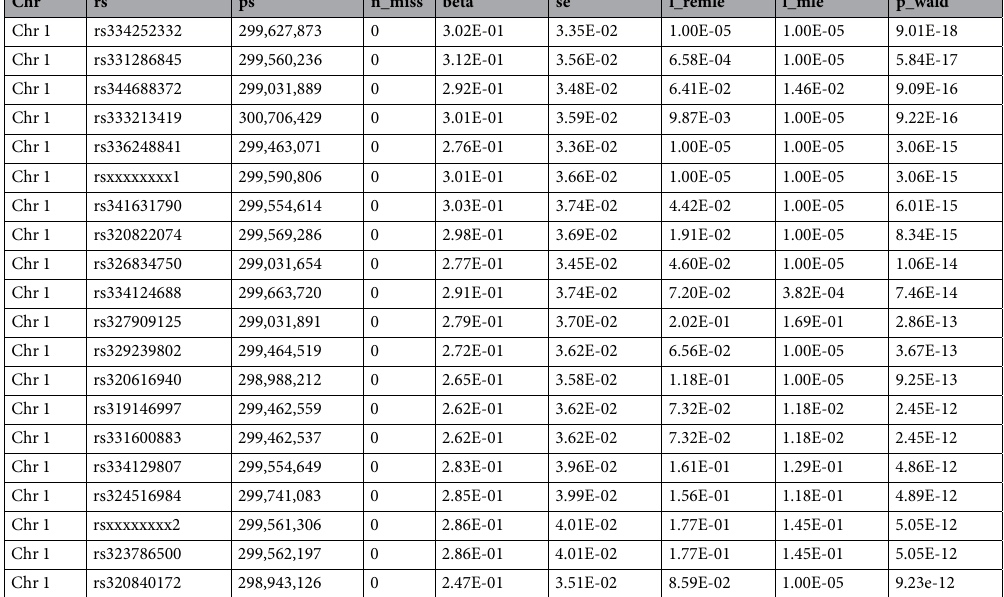
Table 3. Description of the most significant 20 SNPs associated with lumbar number by GWAS. Chr : chromosome number; rs : SNP IDs and two SNPs that do not possess rs ID were named after rsxxxxxxxx1 and rsxxxxxxxx2, respectively, by the author; ps : base pair positions on the chromosome; n_miss : number of missing values of the SNP; beta : beta estimates; se : standard errors for beta; l_remle : remle estimates for lambda; l_mle : mle estimates for lambda; p_wald : P value from the Wald